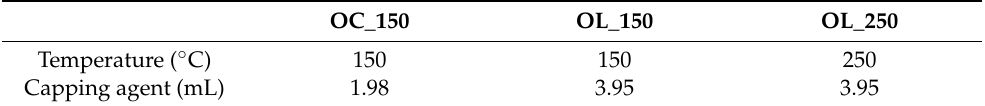
Table 1. Experimental parameters for coated CeO 2 -NPs synthesis. Variation of capping agent and/or temperature results in different size and shape of NPs without changing the core